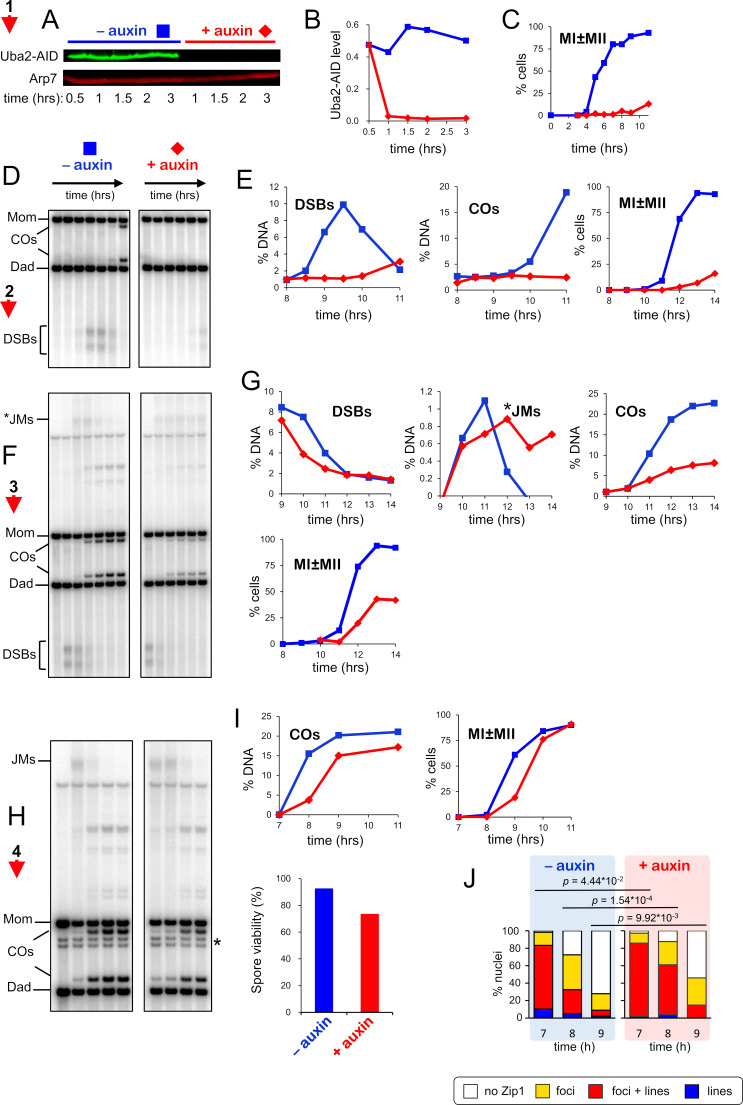
SUMO execution-point analysis using the Uba2-AID degron allele.(A) Immunoblot showing the degradation of Uba2-AID after addition of auxin. (B) Quantification of the blot shown in (A). (C) Meiotic nuclear divisions (MI ± MII) for experiment 1 (see Figure 3A for details of experiments 1–4) (D) 1D gel Southern blot image for analysis of DSBs and crossovers in experiment 2. (E). Quantification of DSBs, crossovers, and meiotic divisions for experiment 2. (F) 1D gel Southern blot images for experiment three used to quantify DSBs, crossovers (COs), and joint-molecules (JM) recombination intermediates. (G) Quantification of DSBs, JMs, COs, and meiotic divisions for experiment 3. *JMs were quantified from the 1D Southern analysis. (H) 1D gel Southern blot image for experiment 4. Asterisk indicates cross-hybridizing bands. (I) Quantification of COs and meiotic divisions for experiment 4. Spore viability was also analyzed (lower bar graph) and shown to be statistically lower following Uba2-AID degradation at the time of IN-NDT80 expression (91.5% vs 76.4%, p<0.04, t-test). (J) Quantification of synapsis (Zip1-staining classes) for experiment 4 indicates that SC disassembly is delayed (p values are shown for G-test analysis).